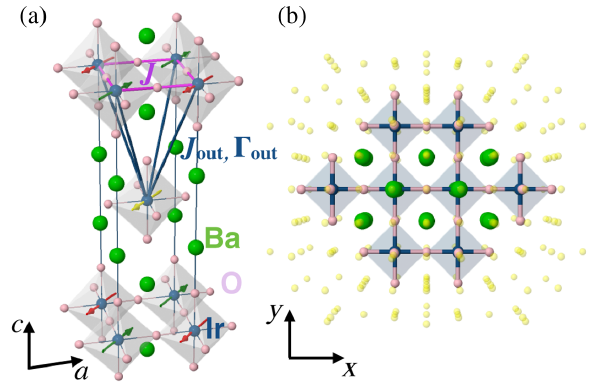
FIG. 1. (a) Layered crystal structure of Ba 2 IrO 4 . In-plane and interlayer exchange paths are shown. (b) Sketch of the cluster used for the calculation of the in-plane NN magnetic interactions. It consists of a central [Ir 2 O 11 ] fragment of two corner-sharing IrO 6 octahedra and six other adjacent octahedra; see text. Ir, O, and Ba ions are shown in blue, pink, and green,